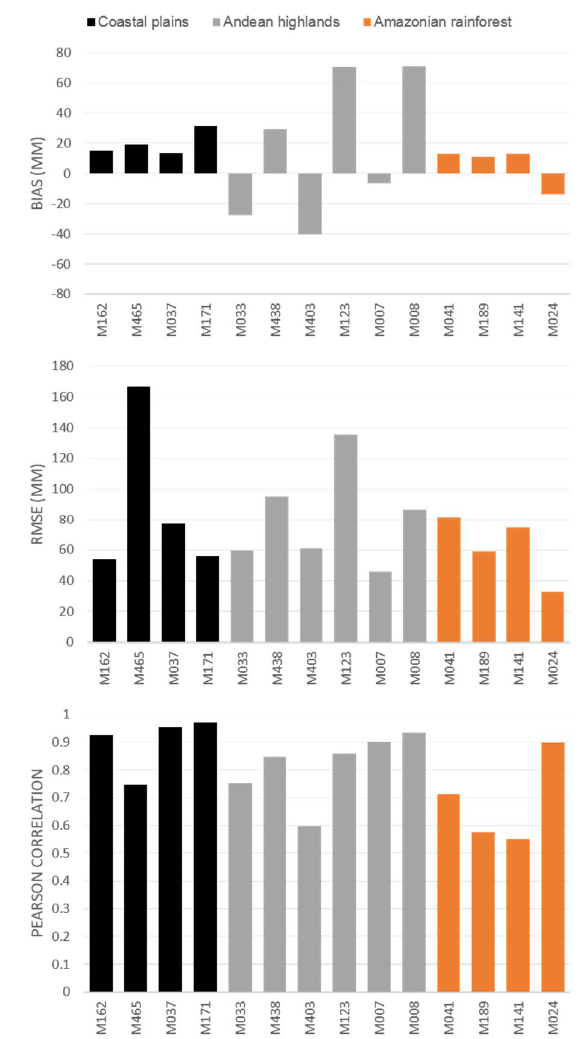
Figure 3. Bias, RMSE and Pearson correlation coefficient for the Coastal plains (black), Andean highlands (grey) and Amazonian rainforest (orange) There was a moderately high bias for the Andean highlands (28 Figure 2. Precipitation regime representation by mean monthly mm) and Amazonian rainforest (25 mm), while the lowest bias precipitation estimates of rain gauges (lines) and TRMM 3B43 values were located on the Coastal plains (19 mm). Rain gauges (dashed). (a) Pacific coastal plains; (b) Andean highlands with located at high altitudes (Table 1: altitudes between 960 - 2267 unimodal regime; (c) Andean highlands with bimodal regime; m.a.s.l.) were those with the greatest bias, except for the bimodal and (d) Amazonian rainforest. The results for TRMM-M008 regime rain gauges, which, despite being in the highlands and TRMM-M041 are overlaid to be located on the same TRMM pixel.